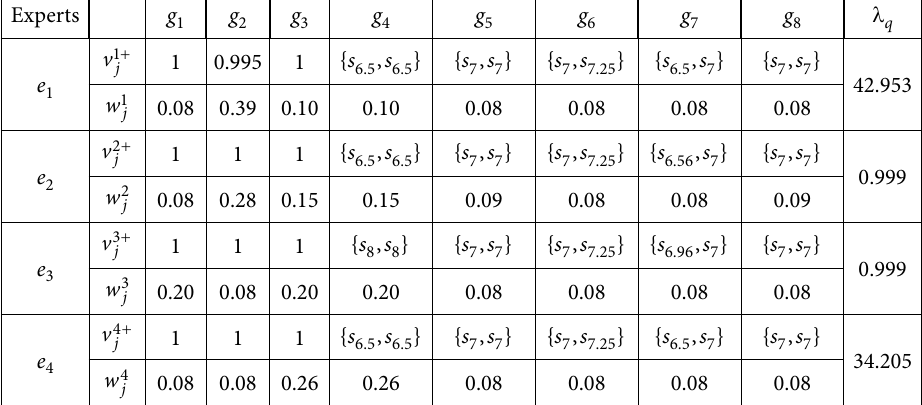
Table 6. The derived attribute weights, compensation parameter and positive ideal solution for each expert Experts